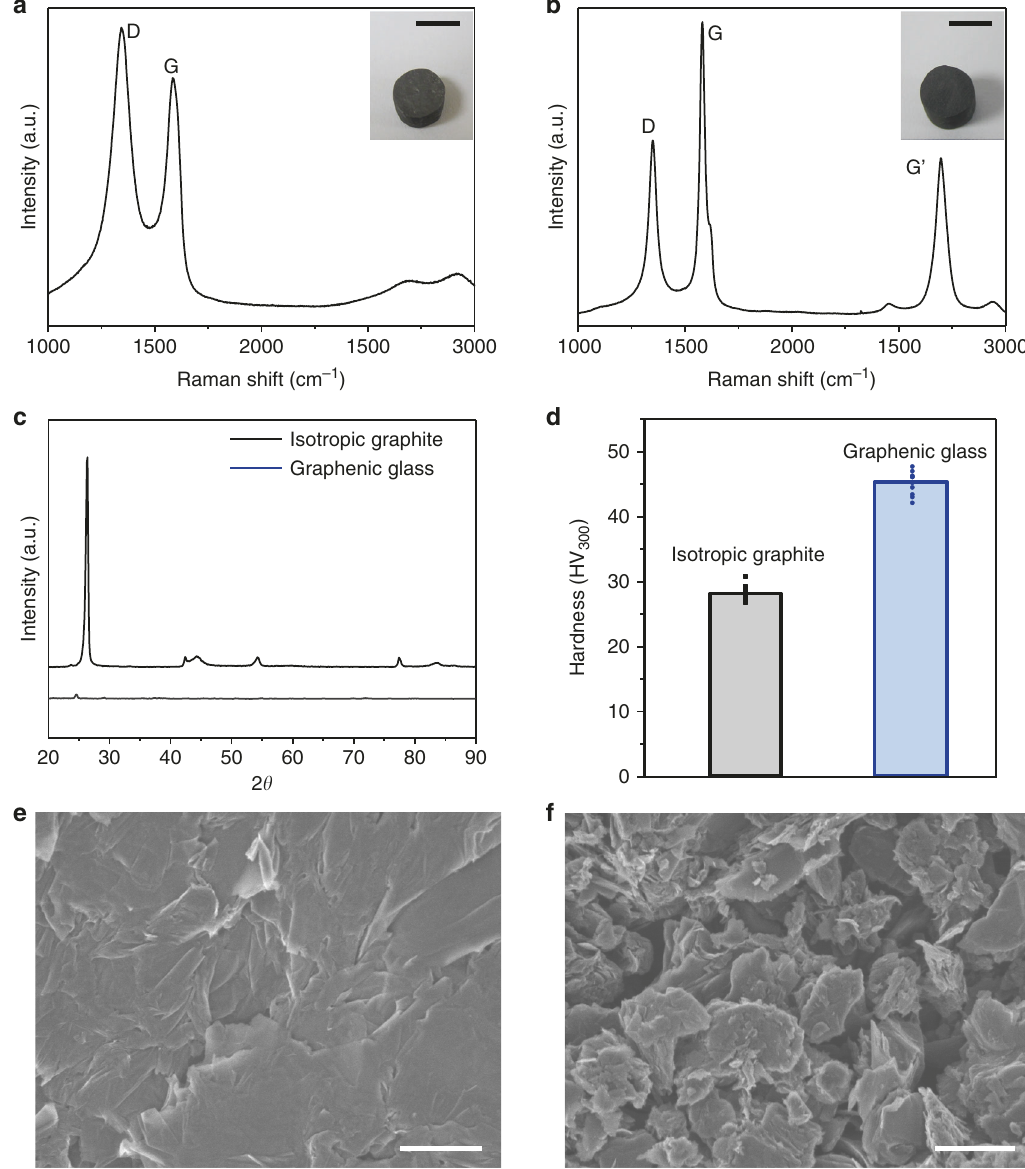
Fig. 7 Glassy graphene solid. Raman spectra of a a graphenic glass and b an isotropic graphite, showing that the graphenic glass is composed of more defective graphene sheets (insets of a , b are photos of the two cylindrical samples). c XRD patterns show that the isotropic graphite is made of highly crystalline graphite grains while the graphenic glass, at similar density, does not have obvious long-range stacking order of the sheets. d Vickers hardness tests show that the graphenic glass is harder than the isotropic graphite, which can be attributed to e its smoother microstructure with fi nely distributed free volume (i.e., voids). In contrast, f the isotropic graphite has a much rougher and more granular microstructure, with much larger voids. Scale bars in a and b insets are 5 mm, and in e and f are 1 μ